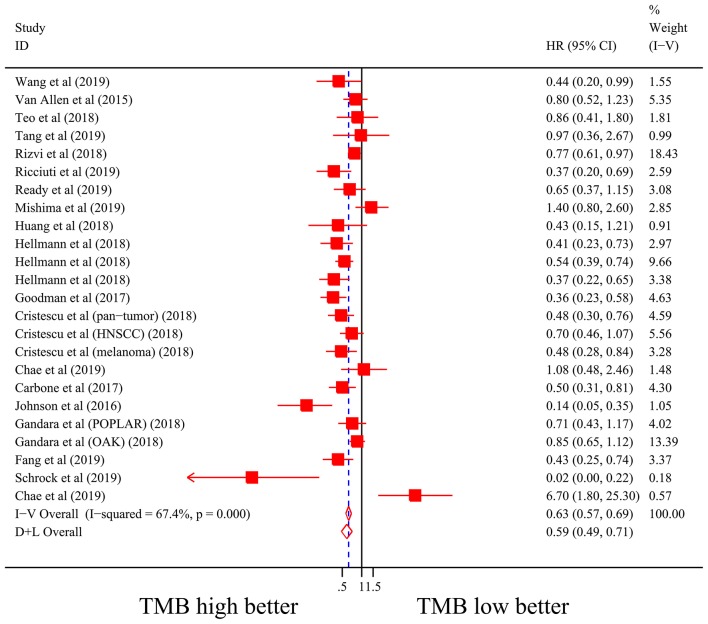
Forest plot of association between TMB and progression-free survival of immune checkpoint inhibitors. HR, hazard ratio; CI, confidence interval; TMB, tumor mutation burden.